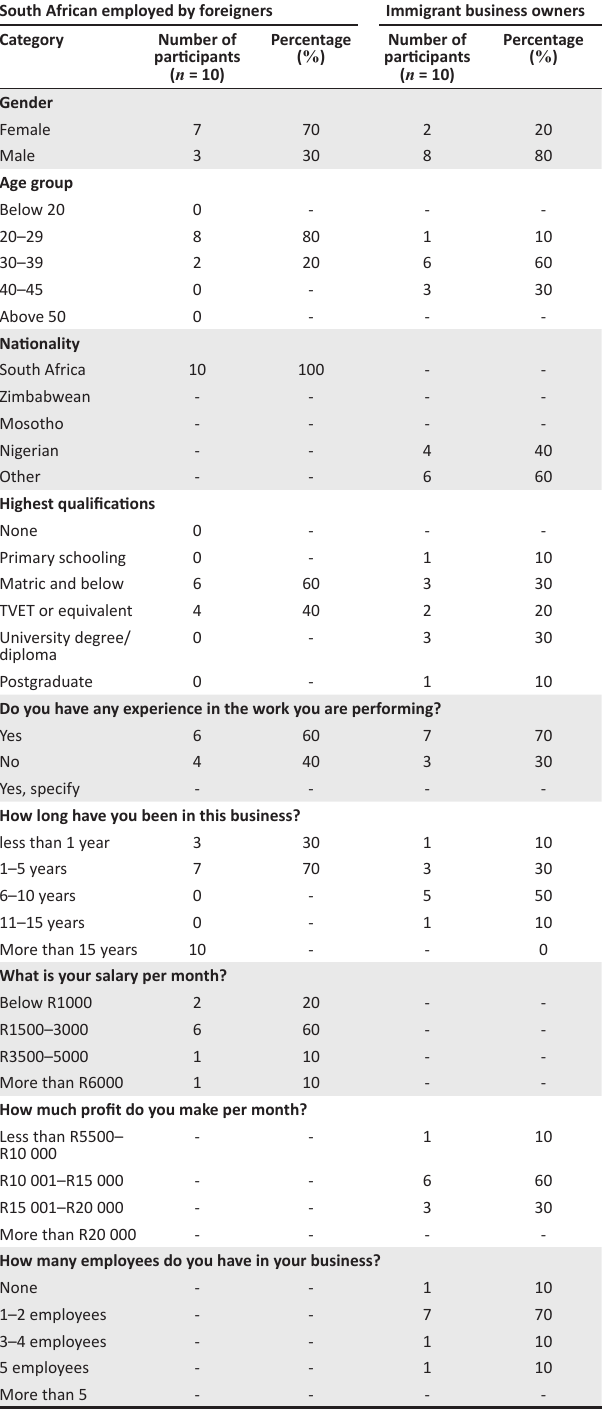
TABLE 1: The demographic data of immigrant business owners and local citizens involved in immigrants’ small retail businesses. South African employed by